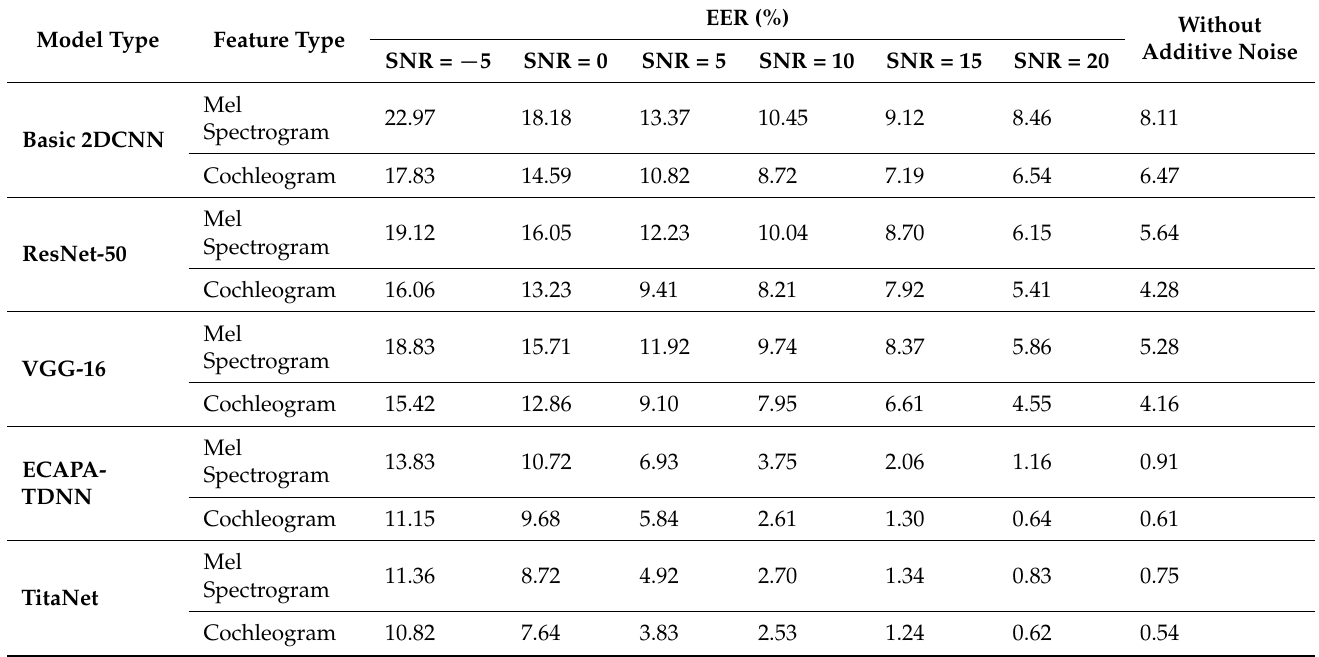
Table 6. Speaker Identification Performance of the Cochleogram vs. Mel Spectrogram with and without additive noises on VoxCeleb1.